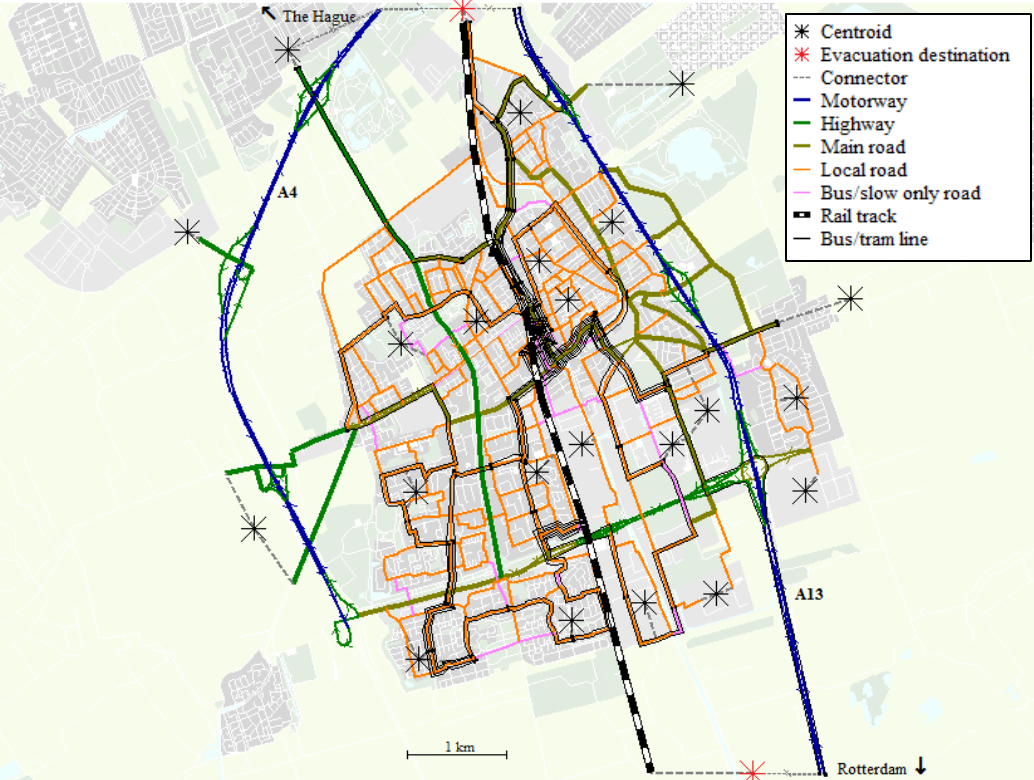
Figure 3. Network of the city of Delft used in our case